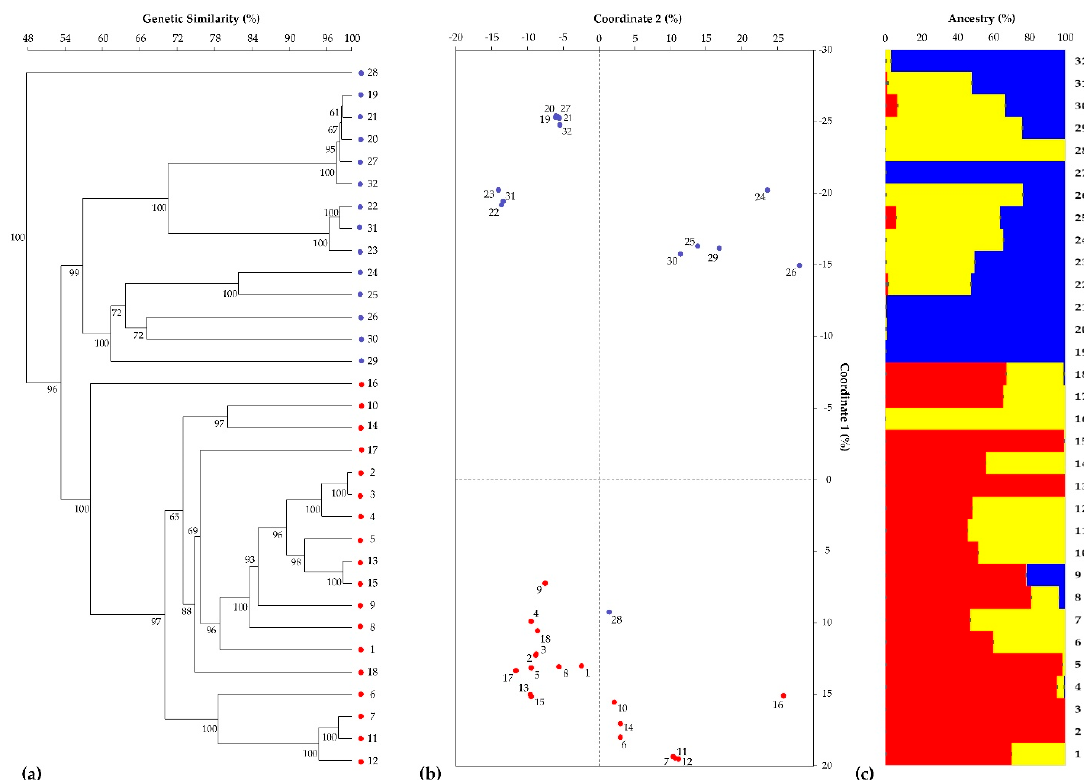
Figure 2. Grouping analysis of 32 endive samples based on 4621 SNP markers. ( a ) UPGMA dendrogram of genetic similarity estimates computed among pairwise comparisons of individual samples using the Jaccard coe ffi cient. Bootstrap estimates ≥ 30% are reported next to the nodes (red and blue dots highlight the two endive cultivar types, C. endivia var . latifolium and C. endivia var . crispum ). ( b ) PCoA centroids derived from the analysis of genetic similarity estimated with Jaccard’s coe ffi cient (red and blue dots correspond to the individual samples of the two cultivar types, C. endivia var . latifolium and C. endivia var . crispum ). ( c ) Population genetic structure of the 32 endive samples as estimated by STRUCTURE. Each sample is represented by a vertical histogram partitioned into K = 3 colored segments (red, blue, corresponding to ( a ) and ( b ), or yellow) representing the estimated membership. The proportion of ancestry (%) is reported on the ordinate axis, and the identification number of each accession is indicated below each histogram.